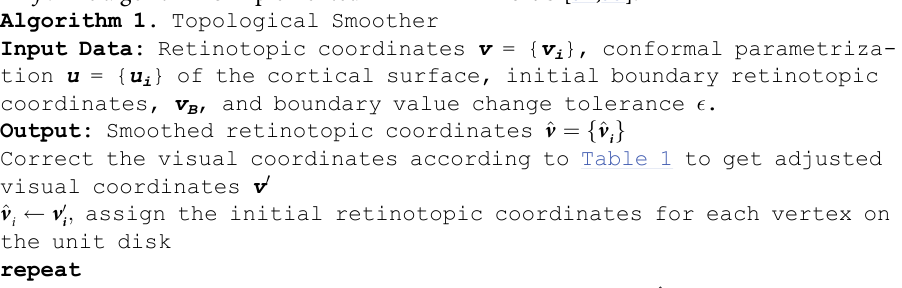
Algorithm 1 . Topological Smoother